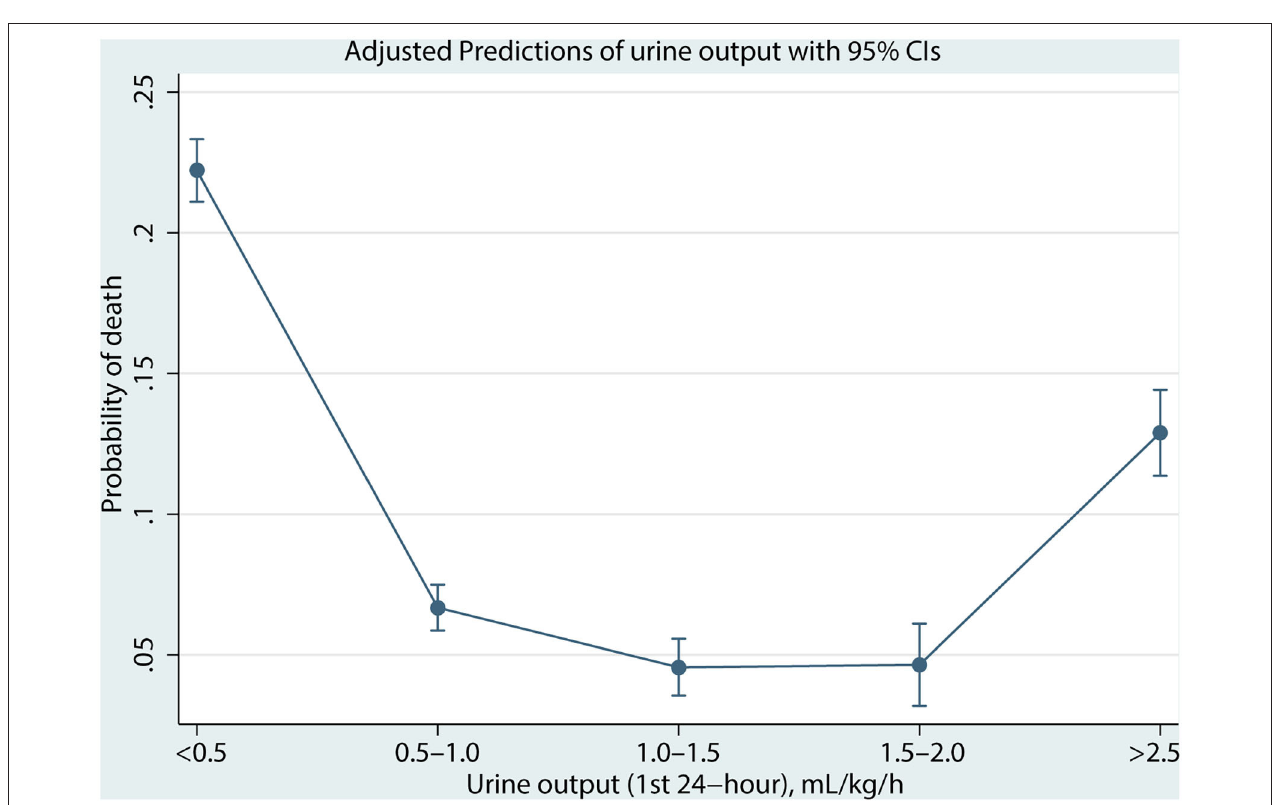
FIGURE 3 | The predictive marginal effect of urine output in different